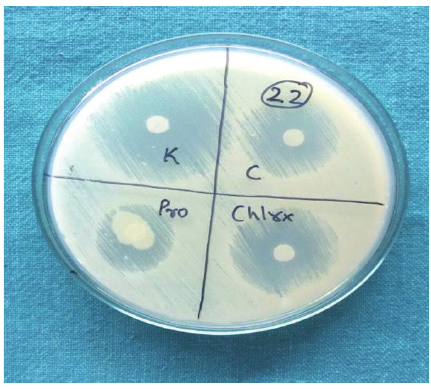
Figure 2: Zone of inhibition observed around the